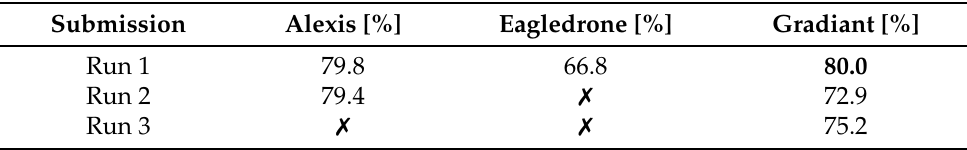
Table 4. Comparison of detection results of the Drone vs. Bird Detection Challenge 2020. Each team was allowed up to three